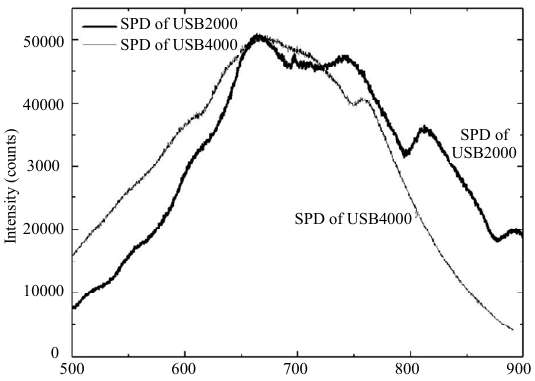
Fig. 11 Spectral power distributions collected by USB2000 spectrometer and USB4000 spectrometer.